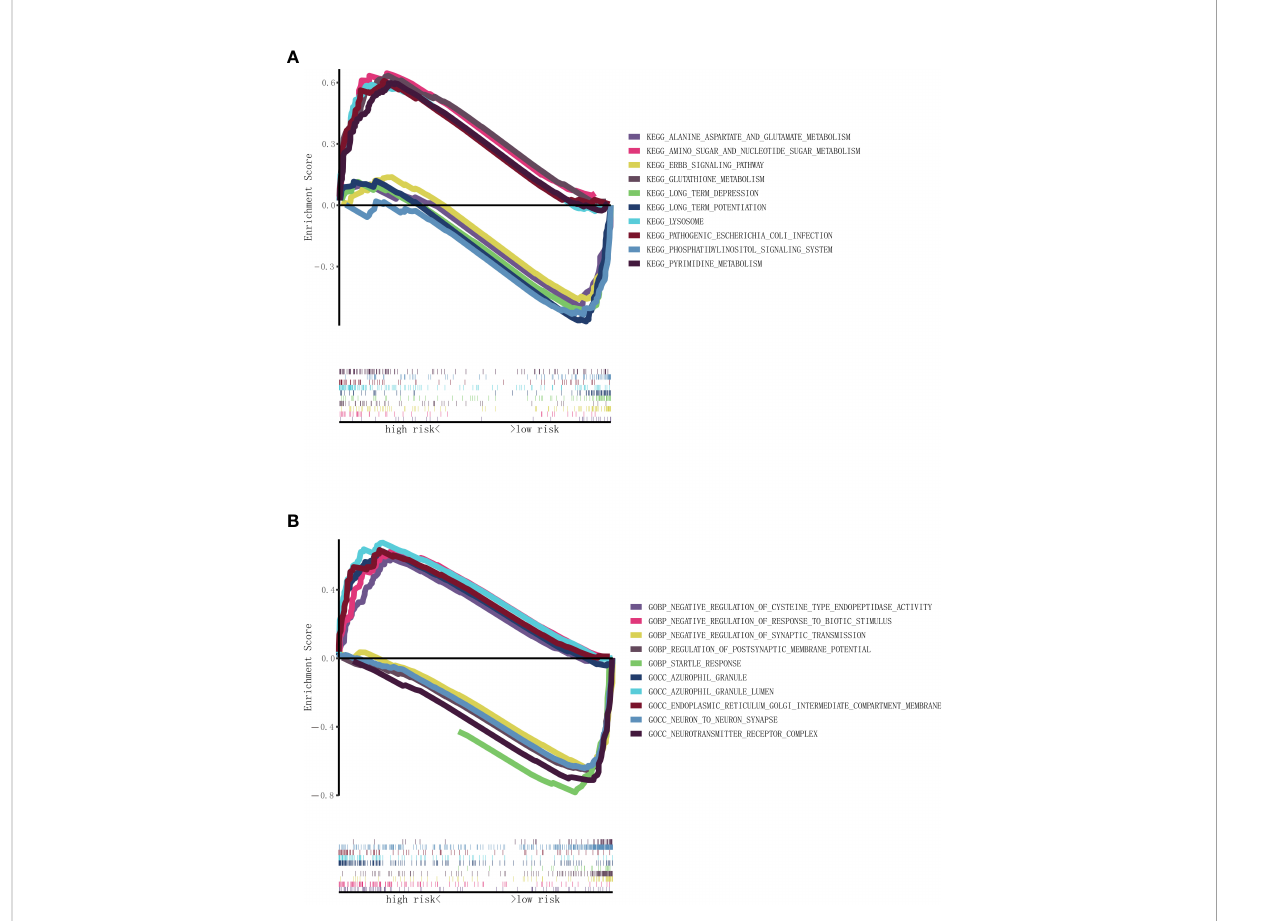
FIGURE 5 Functional enrichment analysis based on nine necroptosis-related lncRNAs between the two risk groups in TCGA. (A) KEGG analysis of nine necroptosis-related lncRNAs. (B) GO analysis of nine necroptosis-related lncRNAs. lncRNAs, long non-coding RNAs; TCGA, The Cancer Genome Atlas; KEGG, Kyoto Encyclopedia of Genes and Genomes; GO, Gene